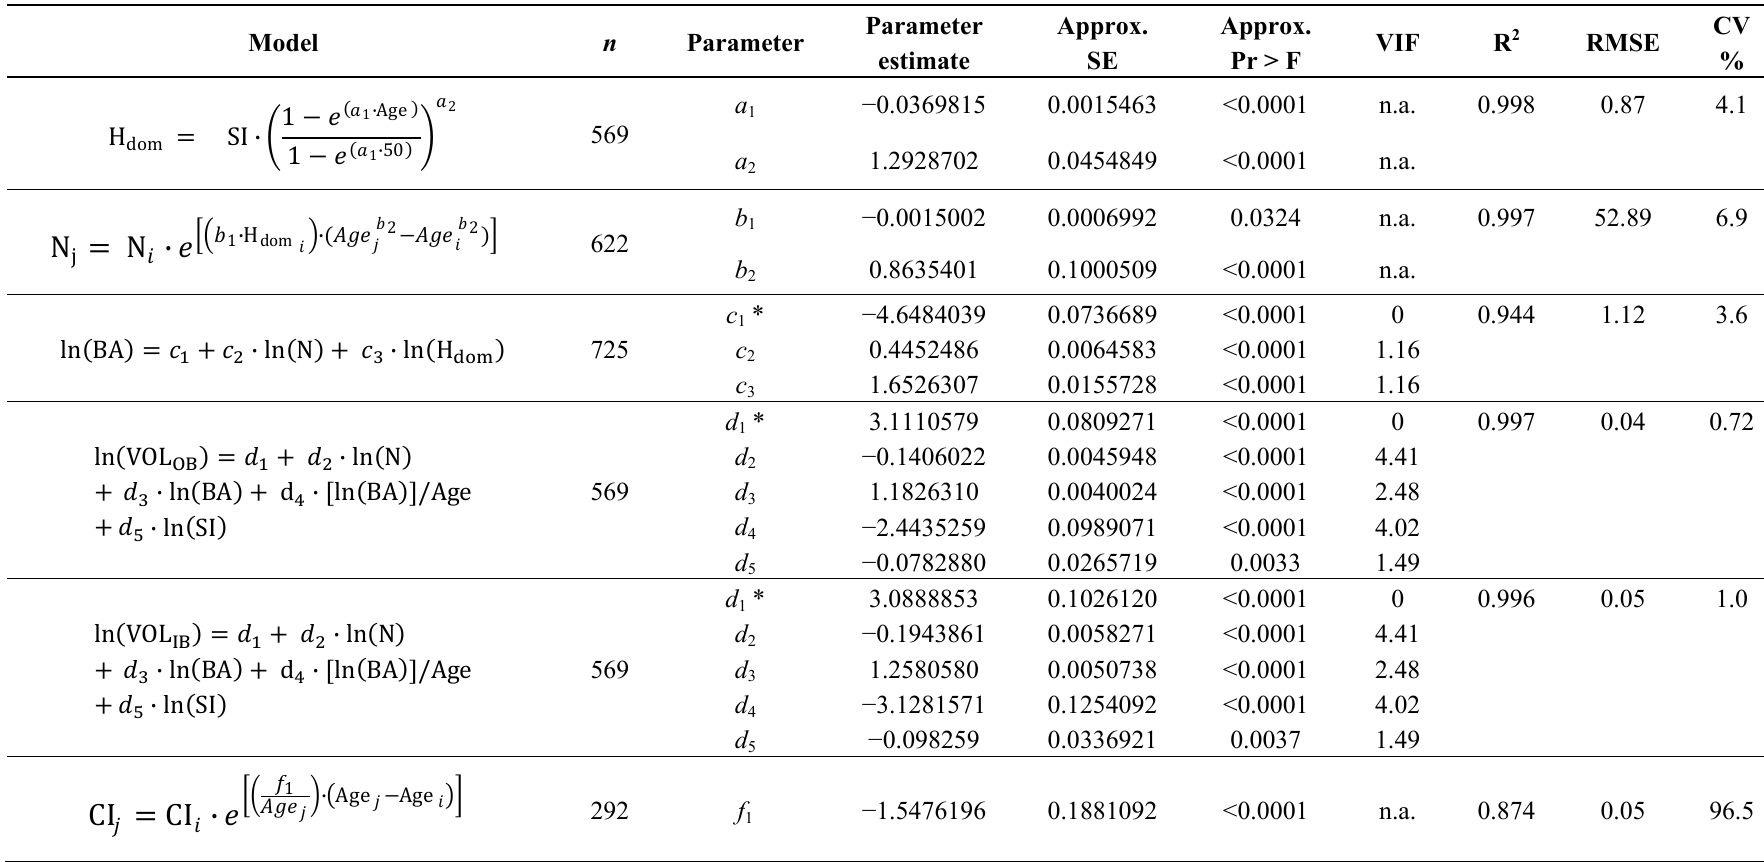
Parameter estimate